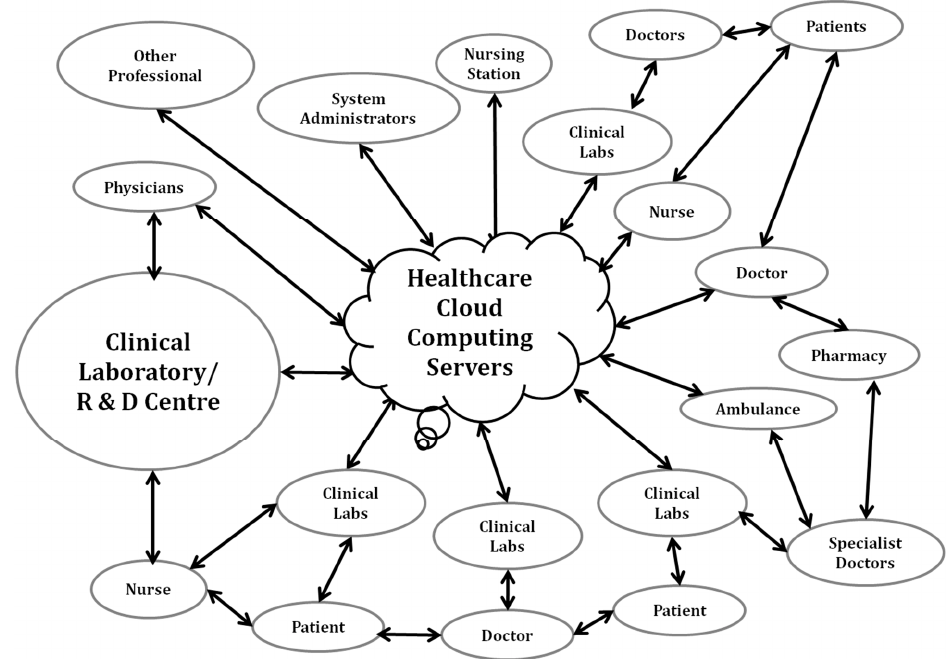
Figure 11. Cloud computing servers for Healthcare.